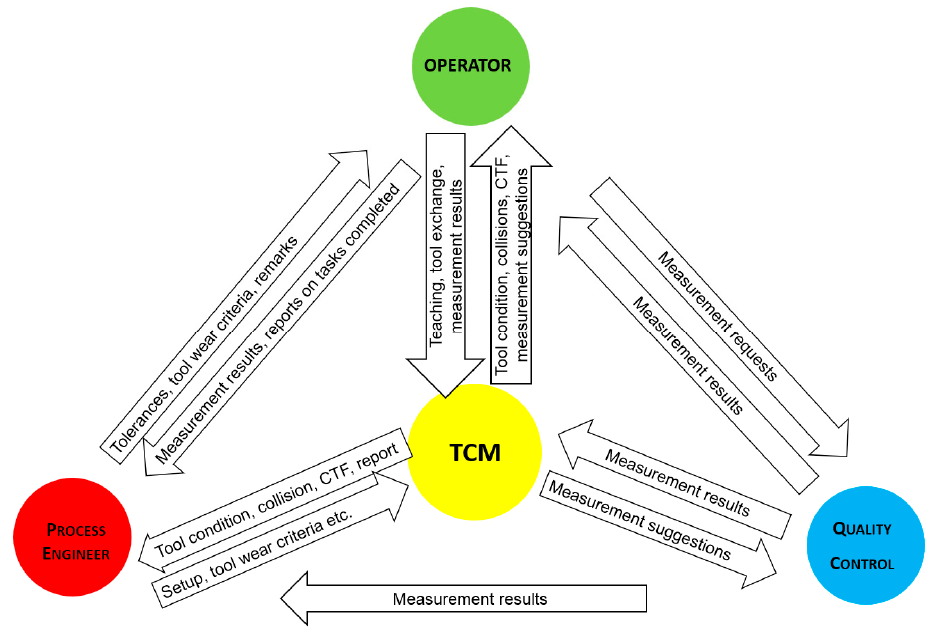
Figure 2. Information flow in the manufacturing process management system [46].